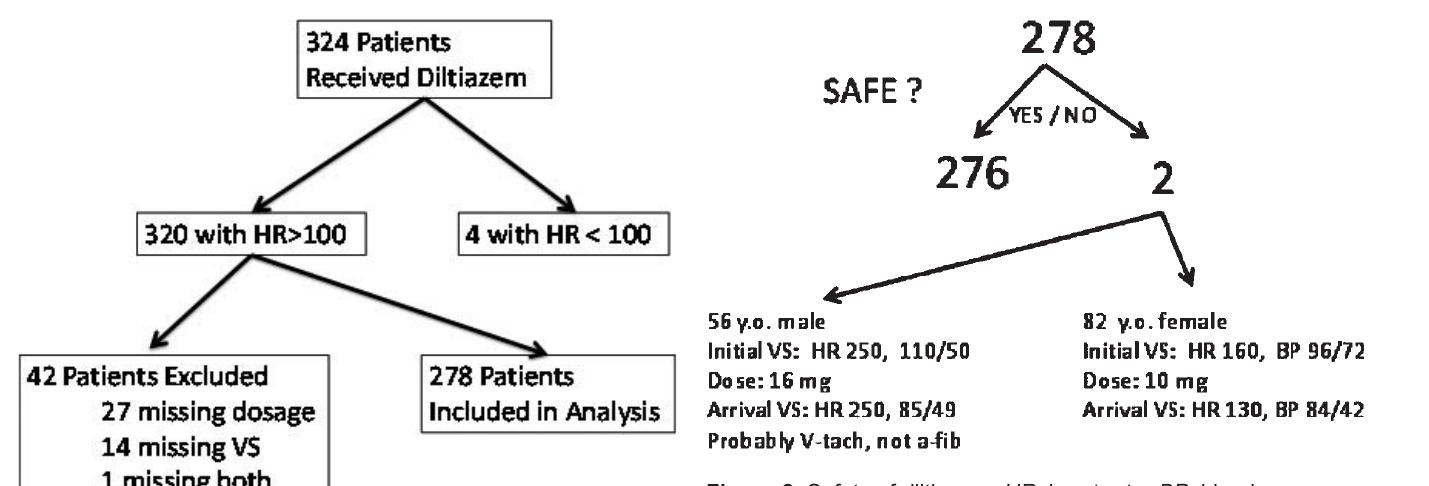
Figure 2. Safety of diltiazem. HR , heart rate; BP , blood pressure.